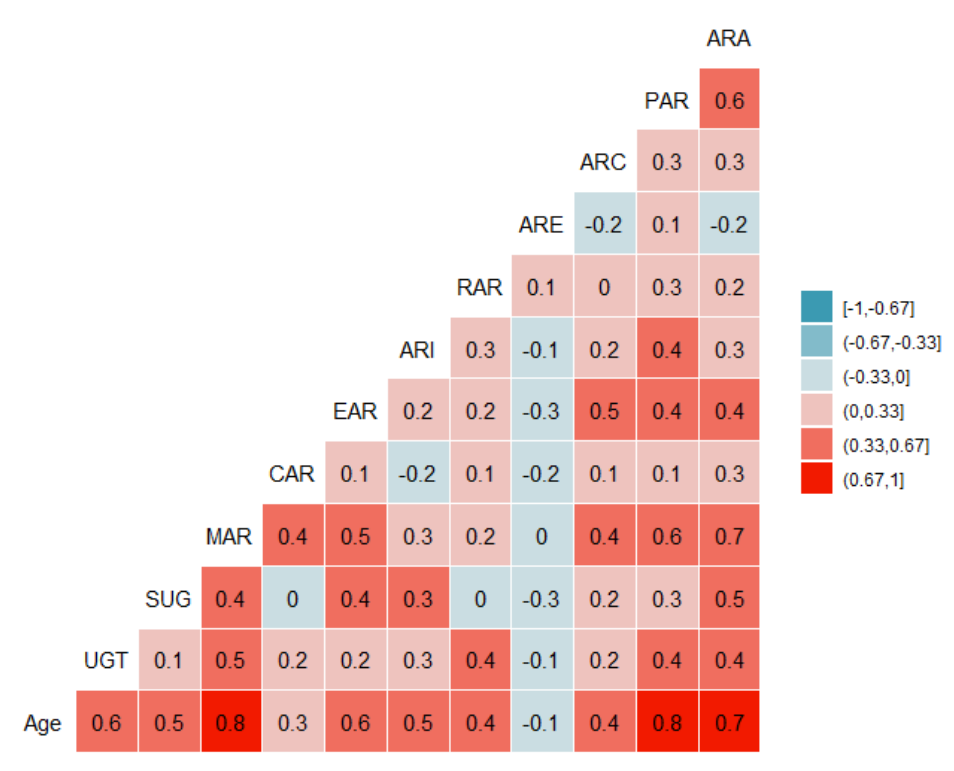
Figure 3: Matrix of plots with a indicators data